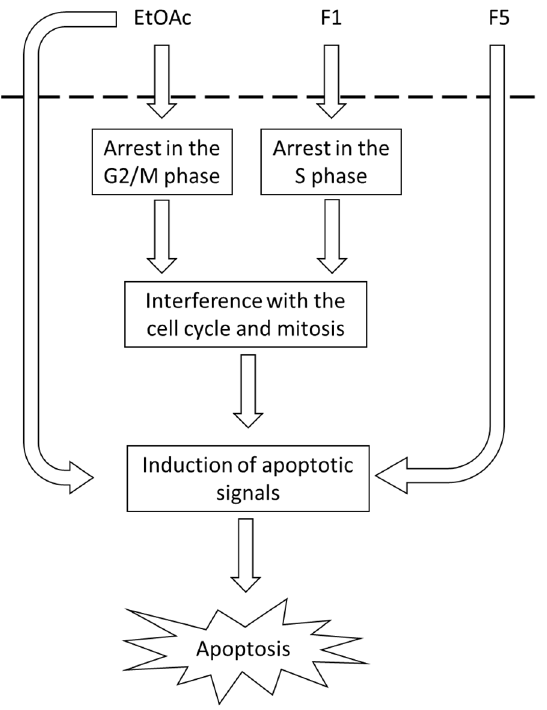
Figure 8. Schematic representation of the antitumor mechanism of F. vesiculosus phlorotannin-rich extract and subsequent fractions in the cell lines tested (Caco-2 and MKN-28).